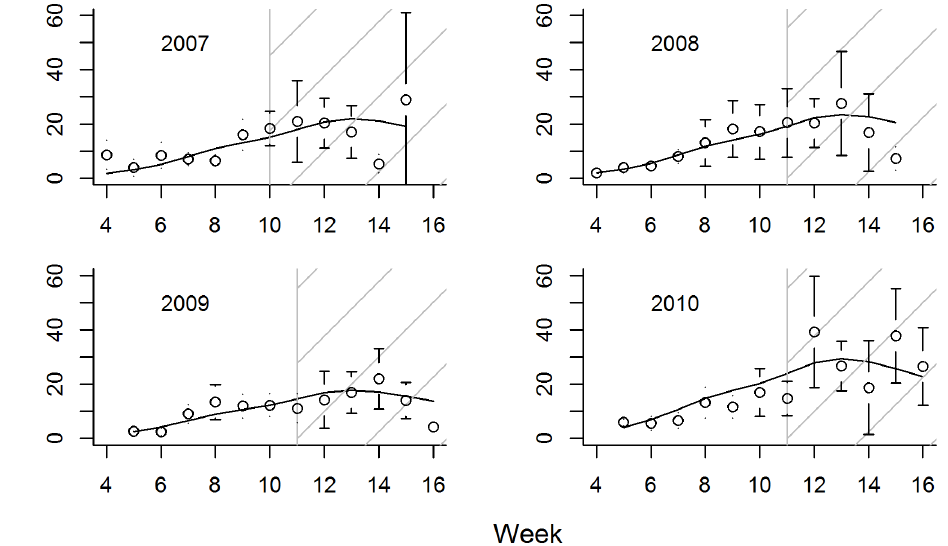
Figure 3. Distances radio-marked ring-necked ducks moved between locations in successive weeks, given they changed lakes. Open circles correspond to observed proportions (with 95% confidence intervals) during the falls of 2007–2010. Solid black line gives predictions from the ‘best-fit’ generalized estimating equation model (chosen using QIC). The gray vertical line (and hatched fill) demarcates the hunting season.